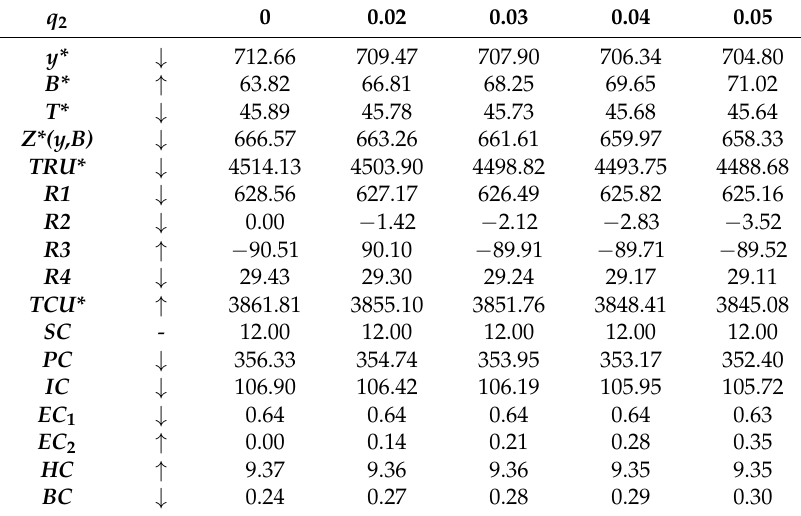
Table 8. Impact of q 2 on an optimal replenishment